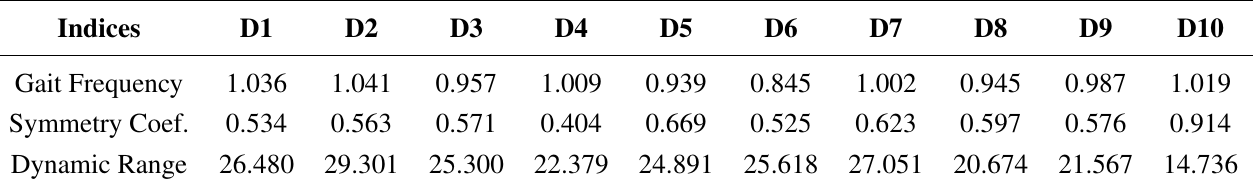
Table 1. Indices for the database. D1 ∼ D10 represent the 10 samples in the database. The units of gait frequency and dynamic range are Hz and m/s 2 ,